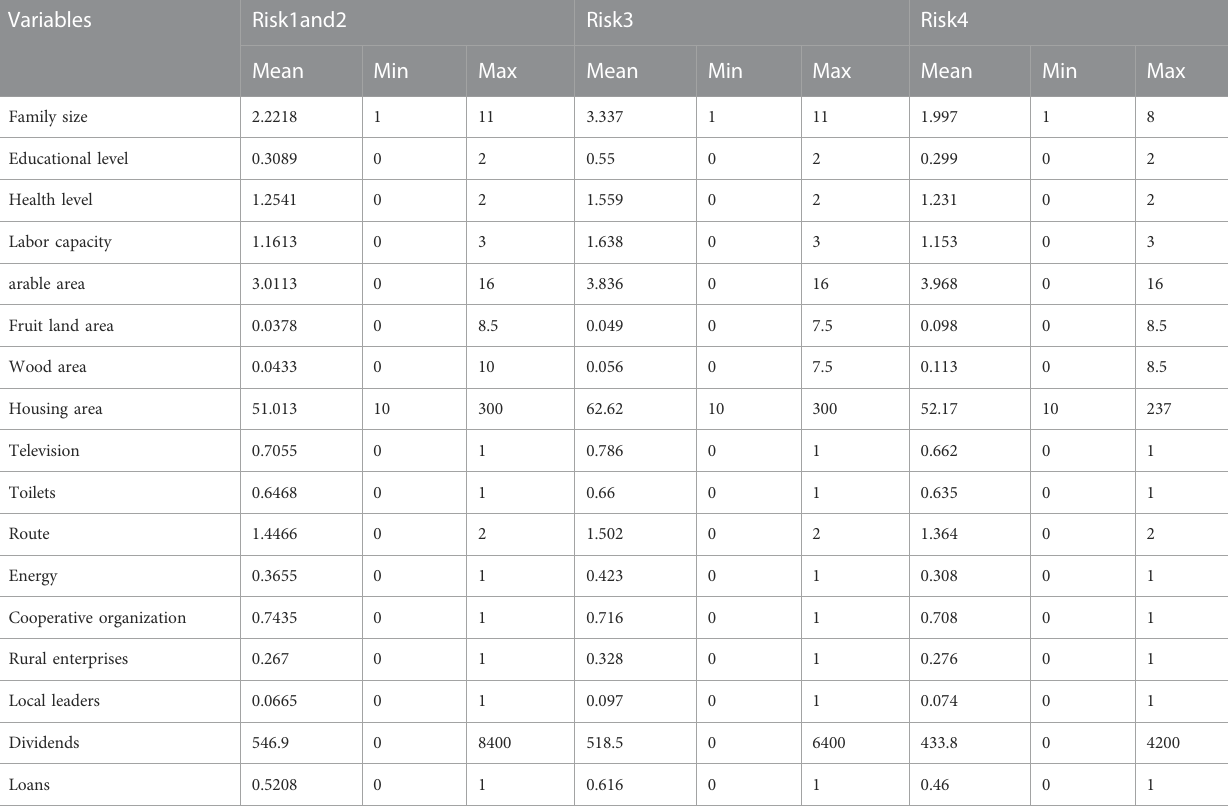
TABLE 3 Relevant variables and descriptive statistical analysis.